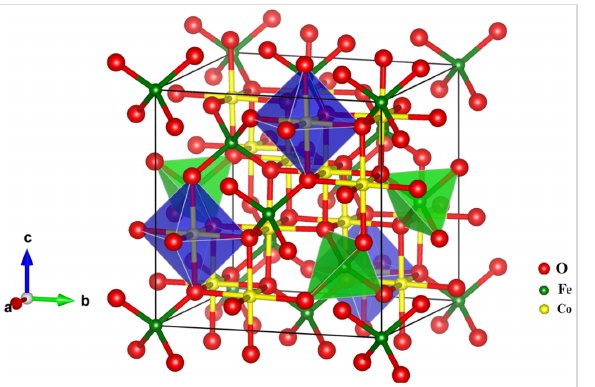
Figure 6: Polyhedral model showing the cubic spinel crystal structure of CoFe 2 O 4 . Green and blue shaded areas correspond to the tetrahed- ral A-sites and octahedral B-sites, respectively.